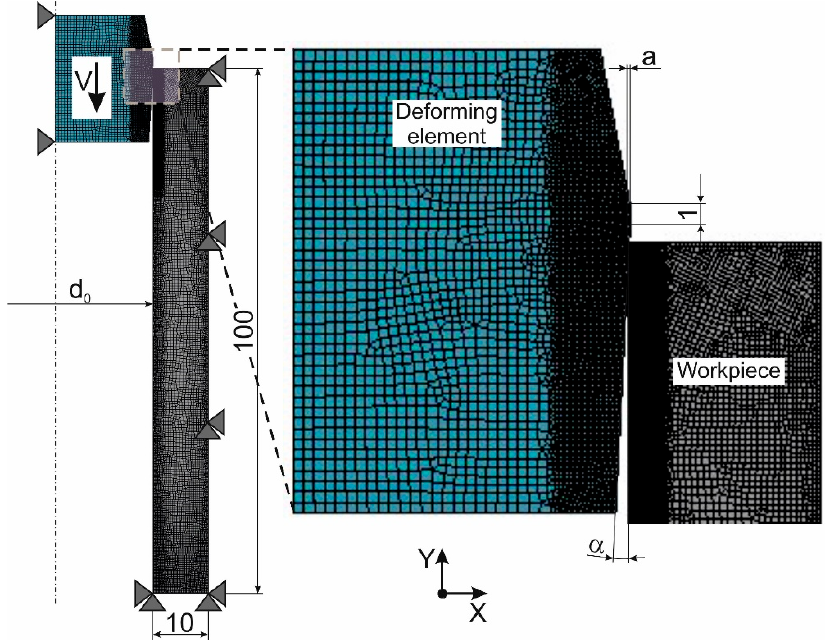
Figure 6. Initial geometry, boundary conditions, and mesh of the DBR FE-model.